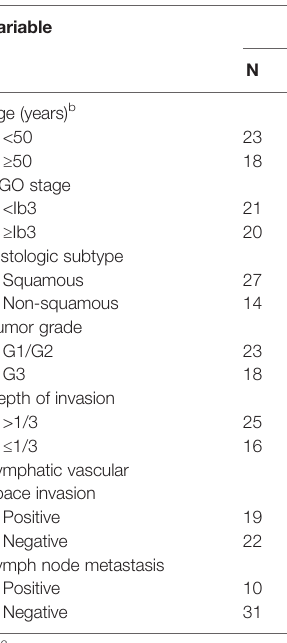
( Figure 3A ). Gene ontology (GO) analysis was performed on 64 targeted genes and the enriched pathways were mainly associated with responses to apoptosis, protein complex binding, prolactin signaling pathway, PI3K-Akt signaling pathway, mutagenesis site, kinase activity, and cytoplasm ( Figure 3B ). CyclinD1 (CCND1) was a vital gene among the 64 predicted target genes